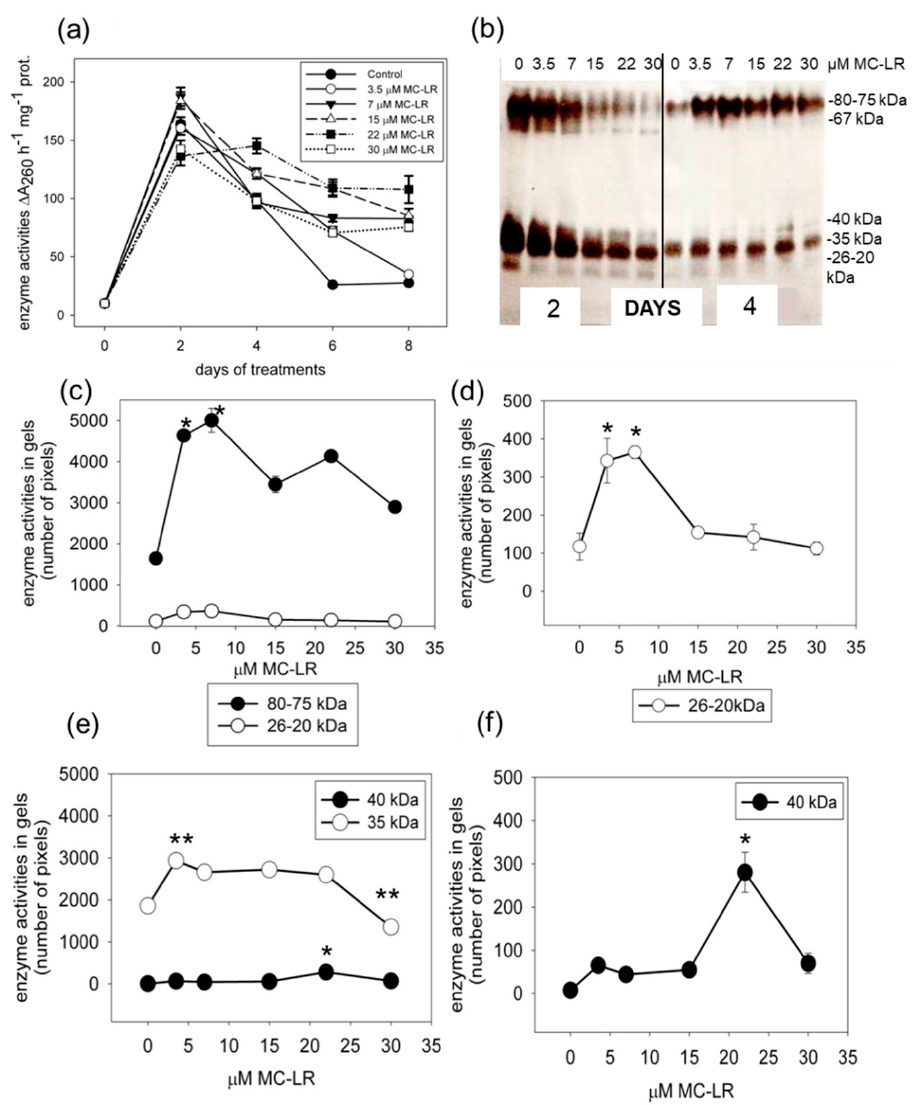
Figure 2. The time- and dose-dependent effects of MC-LR on neutral (assayed at pH 6.8) single-stranded DNase (SSP nuclease) activities of whole S. alba seedlings. ( a ) Time- and toxin-dose-dependent total SSP nuclease activities according to the spectrophotometric assay. ( b ) The in-gel activity assay shows characteristic MC-LR dependent changes in the 80–75, 40–35 and 26–20 kDa isoenzymes at 2 and 4 days of toxin treatments. ( c ) Quantification of activity gels by the CP Atlas method for the activities of the 80–75 and 26–20 kDa isoenzymes shows a clear MC-LR-induced increase for the 80–75 kDa isoenzymes at 4 days of exposure. ( d ) Shows a scale-up chart for the 26–20 kDa isoenzyme to see more clearly the increases induced by MC-LR at 4 days of exposure. ( e , f ) Quantification of the activities of the 40 kDa and 35 kDa isoenzymes. Elevated 40 kDa activity in 3.5–22 µ M MC-LR-treated seedlings and an increase in 35 kDa activity at 4 days of 22 µ M MC-LR treatment shown together in same scaling. ( f ) Shows a scale-up chart for the 40 kDa isoenzyme to see more clearly the increase induced by 22 µ M MC-LR. Whole plant extracts containing 15–15 µ g protein were loaded on 7.5–12.5% gradient gels. Gels were incubated for 17 h/28 ◦ C. The significance of differences between controls’ and treated ones’ enzyme activities were evaluated after the analysis of variance using One-Way ANOVA by Tukey/Holm–Sidak method or t -test, Sigma-Plot; **: significance at p < 0.001; *: significance at p <